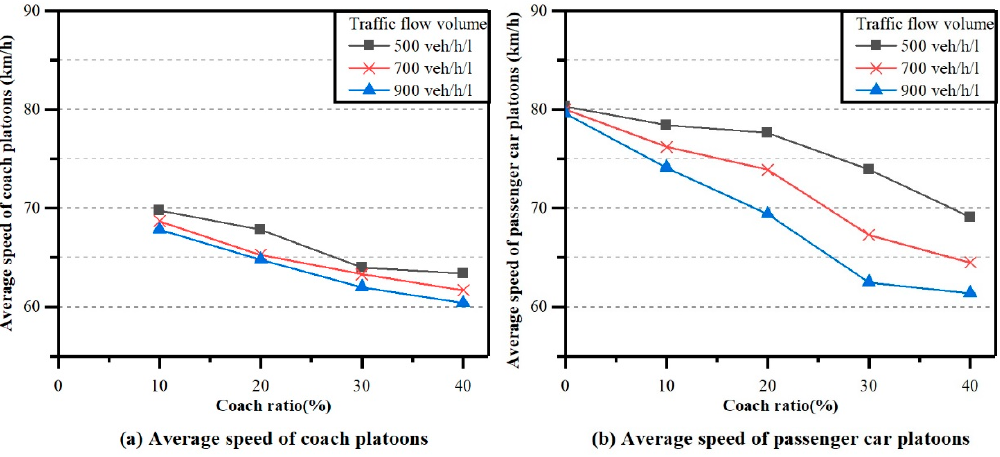
Figure 4. Speed change with respect to the coach ratio in field experiments.